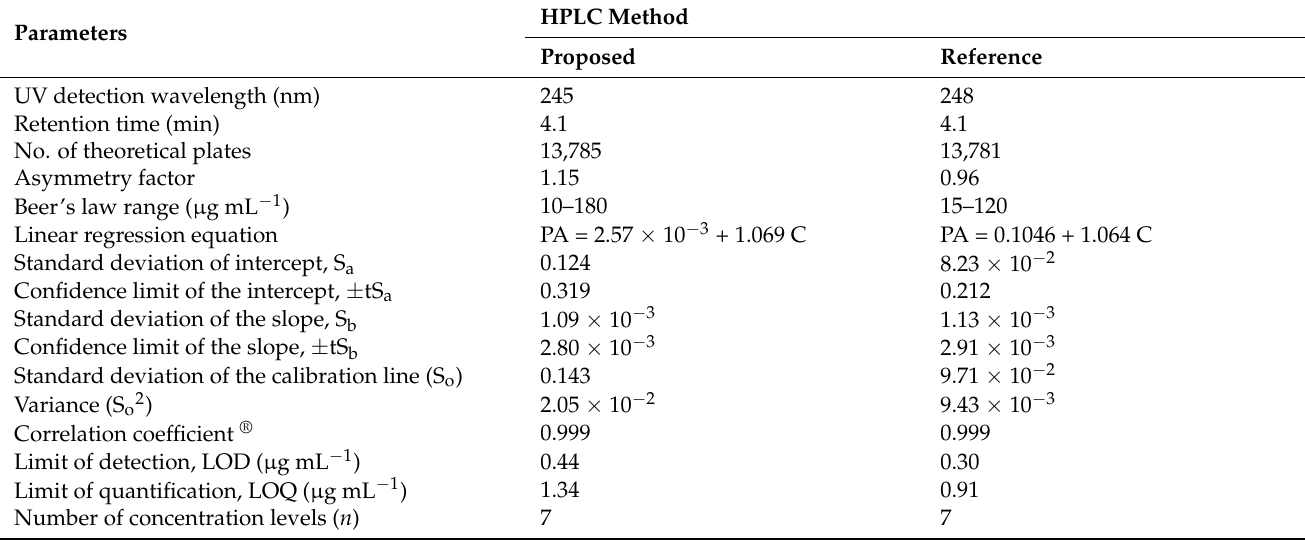
Table 6. Analytical and regression characteristics of the proposed and reference HPLC